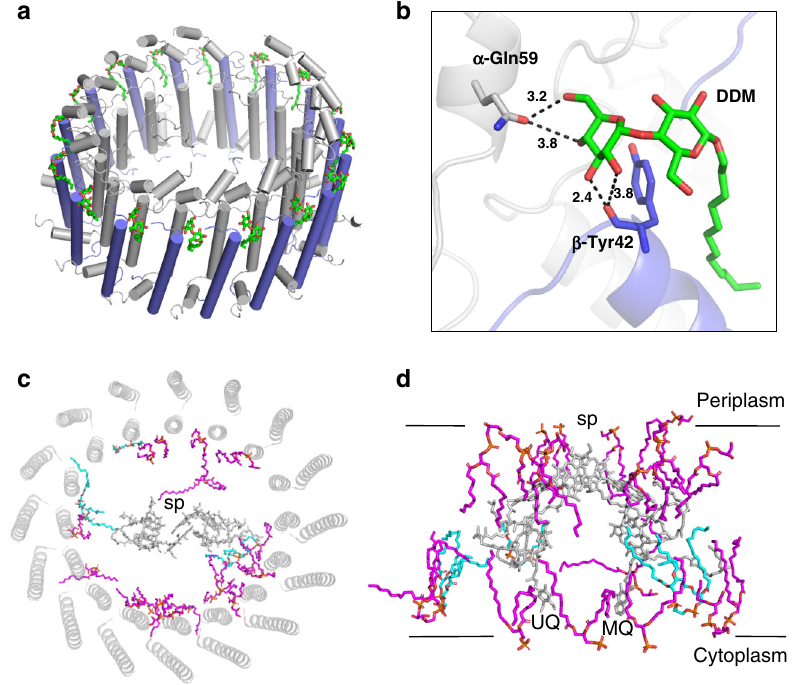
Fig. 5 Detergents and phospholipids associated with the puri fi ed LH1-RC complex. a Tentatively assigned DDM molecules (green sticks) in the LH1 outer ring. b Expanded view of a putative DDM-binding site showing the interactions with the residues in LH1 α - (gray) and β - (blue) polypeptides. All distances are in ångströms. c Phospholipid distribution in LH1-RC viewed from the periplasmic side of the membrane with the special pair (sp) positioned at the center. CL: cyan; PG: magenta. The pigment and quinone (UQ and MQ) molecules in the RC (hemes in the C-subunit were omitted for clarity) and the LH1 polypeptides are colored in gray. d Side view of the phospholipid distribution along the presumed membrane planes. Same color scheme as in c . The LH1 complex was omitted for